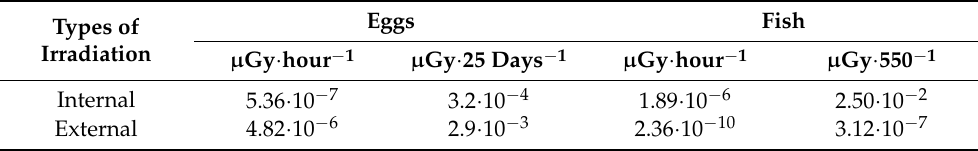
Table 7. Radiation doses for the eggs and